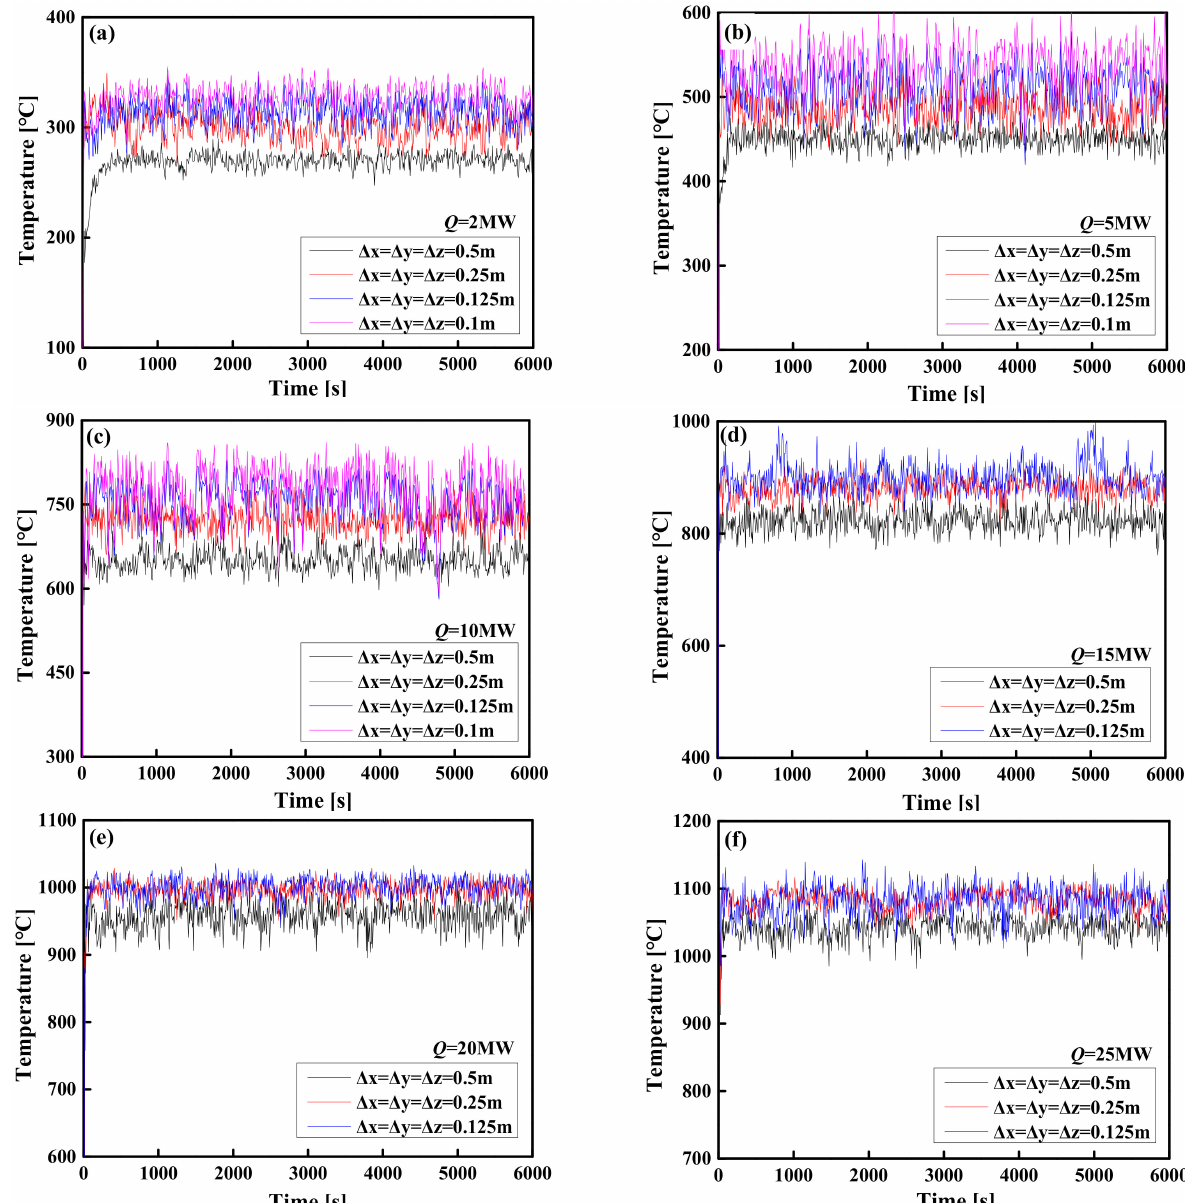
Figure 9. Grid sensitivity analysis: ( a ) Q = 2 MW; ( b ) Q = 5 MW; ( c ) Q = 10 MW; ( d ) Q = 15 MW; ( e ) Q = 20 MW; ( f ) Q = 25